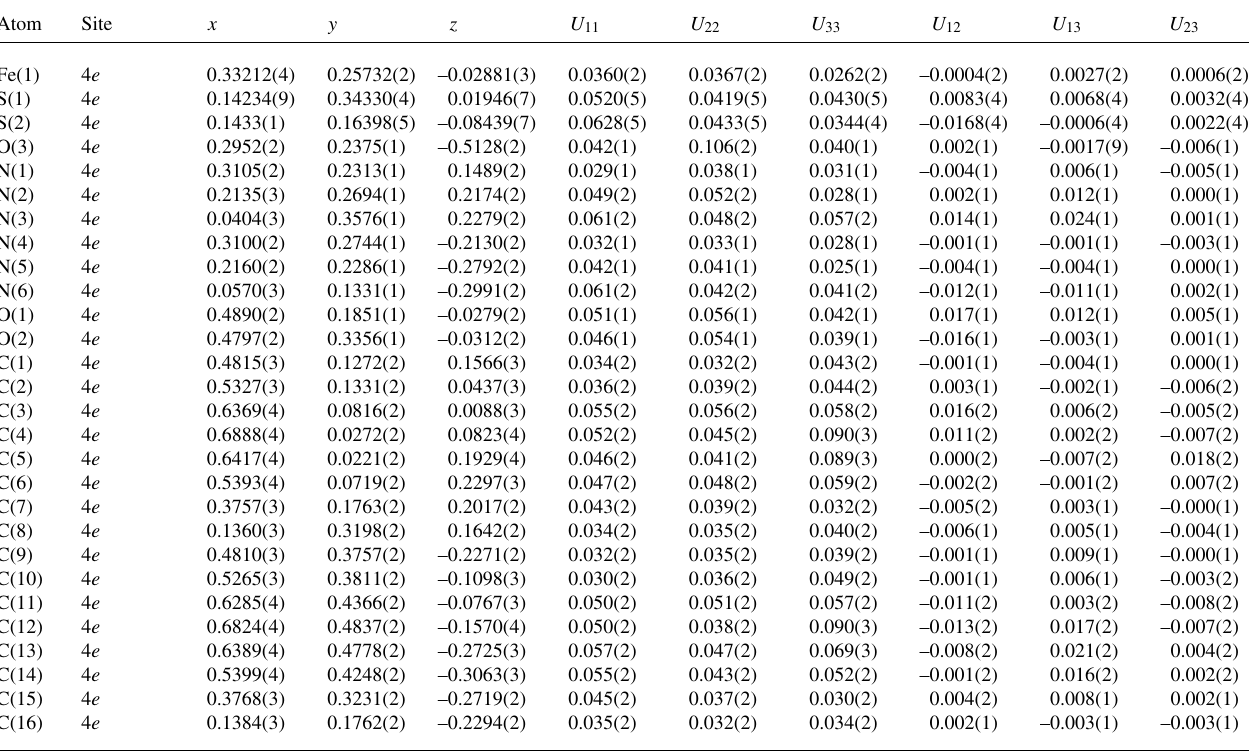
Table 3. Atomic coordinates and displacement parameters (in Å 2 )